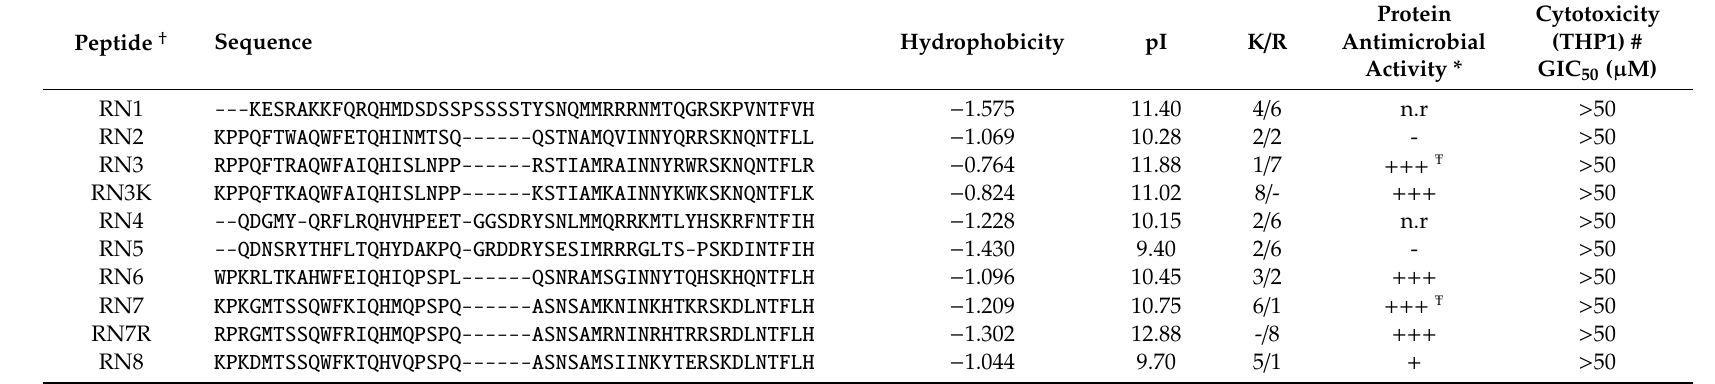
Table 1. Physicochemical and biological properties of the hRNase-derived peptides.